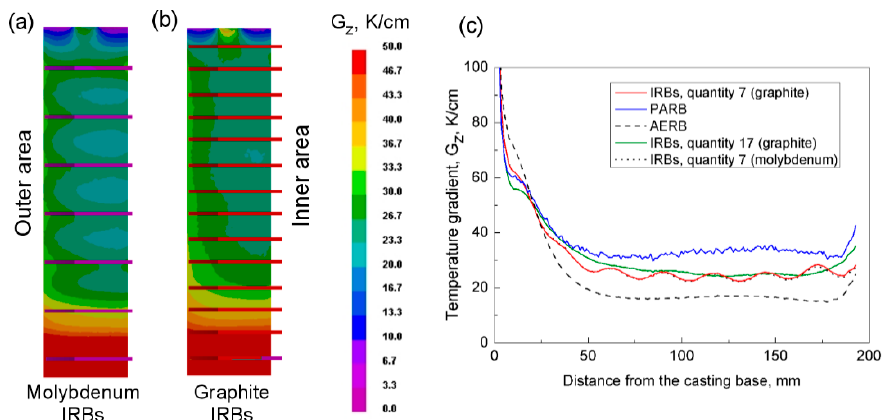
Figure 8. Gy/Gz ratio calculated for liquidus and solidus temperature in the outer, inner, and middle area of casting plate at a distance of 40, 100, 155 mm from its base, for the process with ( a ) adjusted external radiation baffle (AERB); ( b ) inner radiation baffles (IRBs); ( c ) perfectly adjusted radiation baffle (PARB).